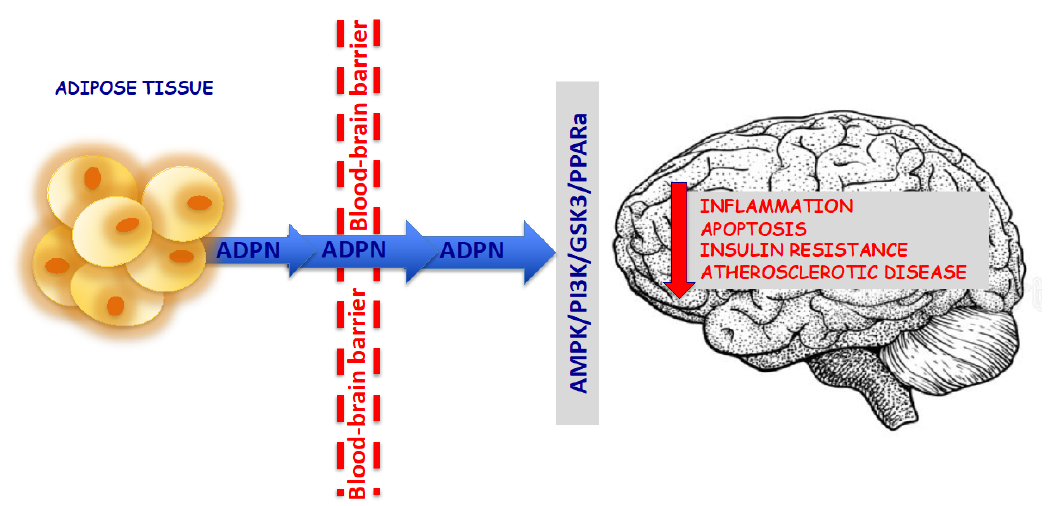
Figure 1. Adiponectin (ADPN) can be considered a molecular of interest in the search for new neuroprotective target for